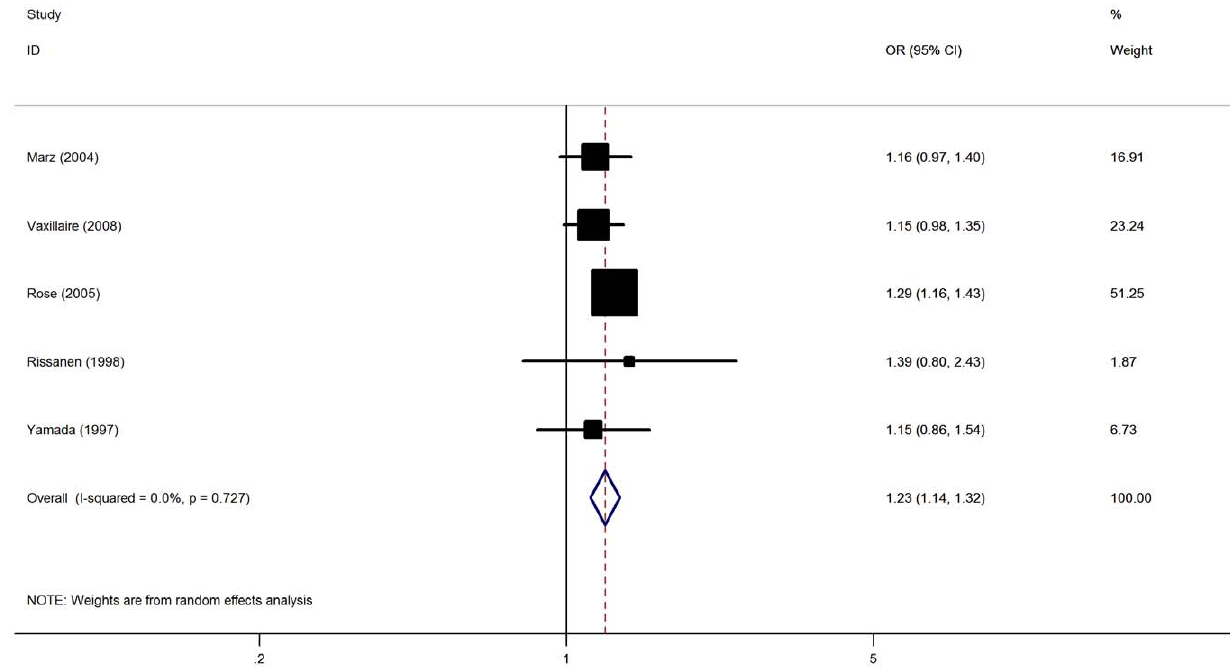
Figure 2. Forest plot for the overall association between the GCK 2 30G . A polymorphism and impaired glucose regulation risk. doi:10.1371/journal.pone.0055727.g002 PLOS ONE |